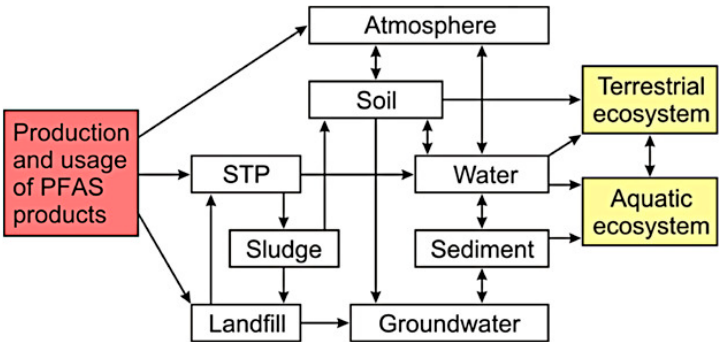
Figure 1. Pathways of PFAS into the environment and their fate. Adapted from Ahrens [53]. STP = sewage treatment plant.